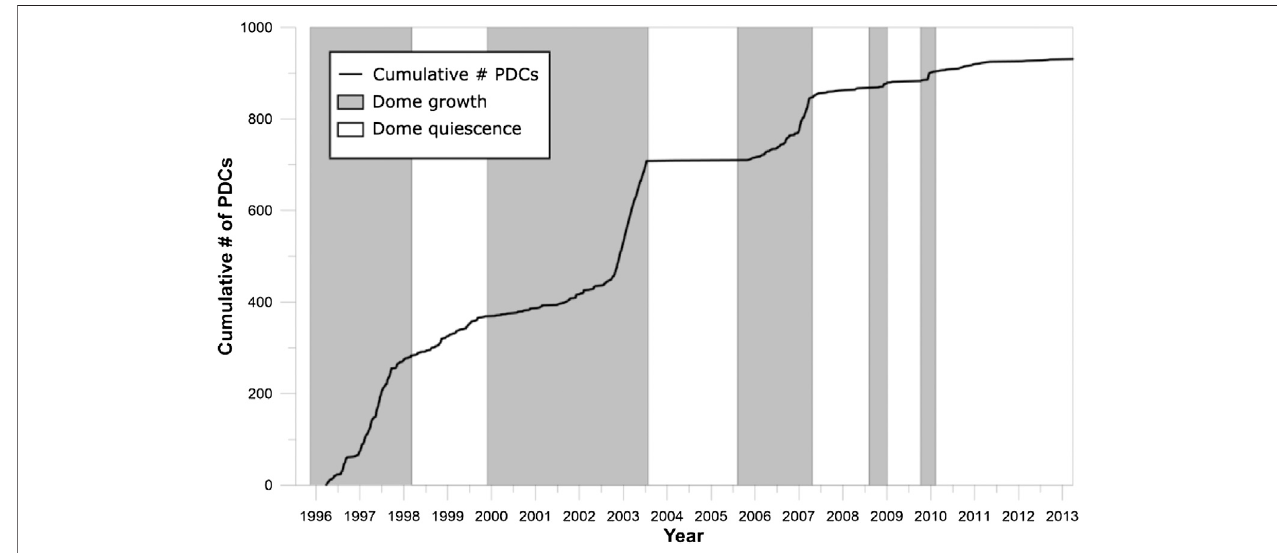
FIGURE 2 | Cumulative number of recorded, dome-collapse PDCs, beginning July 18, 1995 and ending with the last recorded PDC on March 28, 2013. Data are from FlowDat (Ogburn and Calder, 2012; Ogburn and Calder, 2017).